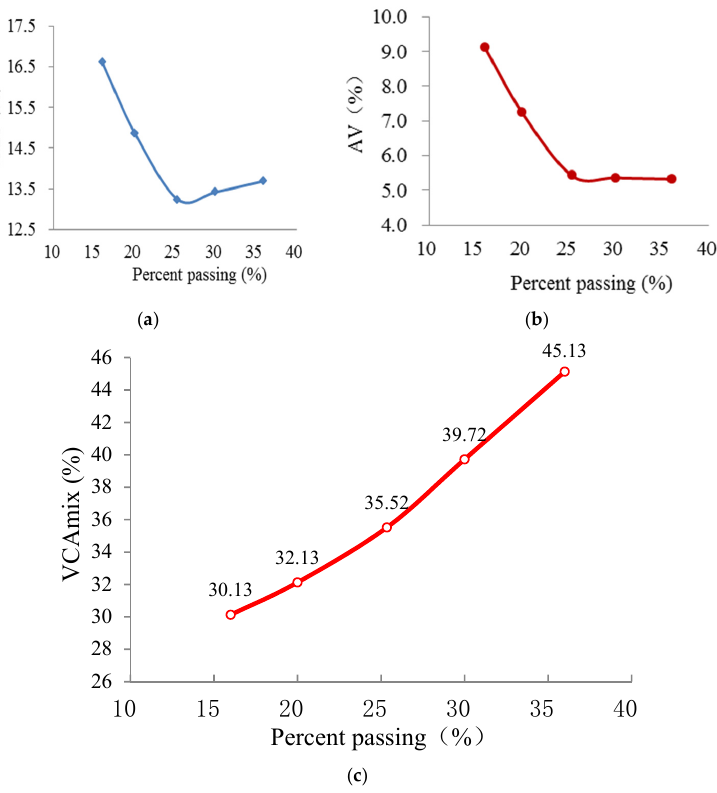
Figure 7. VPs of AC-20 samples versus PP. ( a ) VMA; ( b ) AV; ( c ) VCAmix.